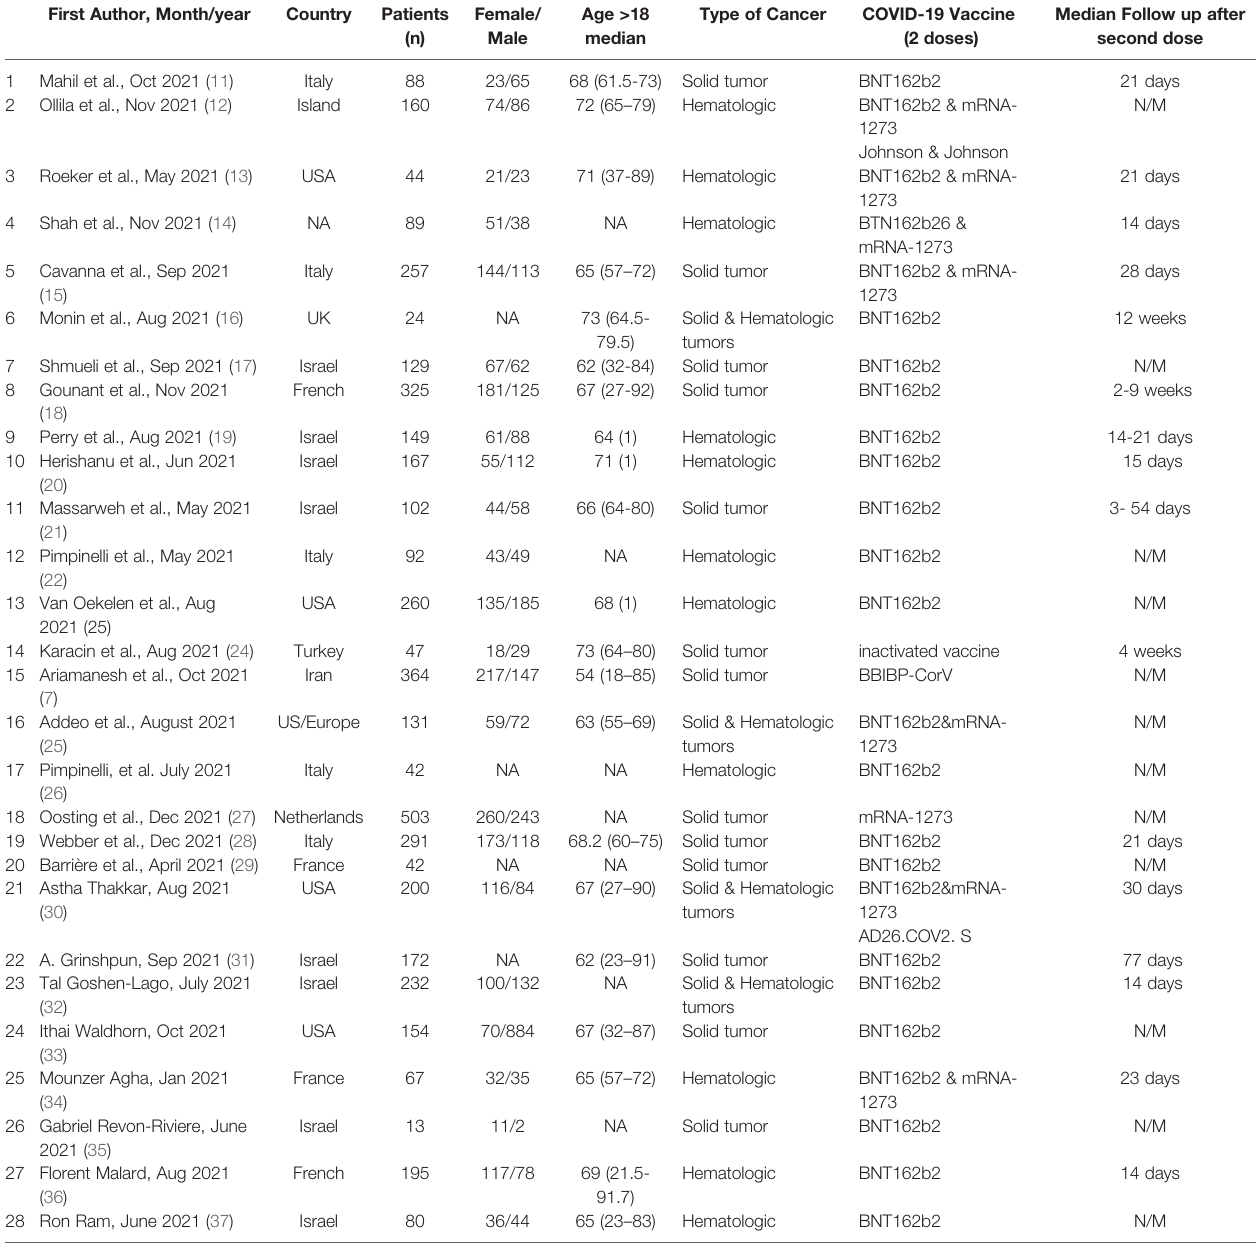
TABLE 2 | Characteristics of enrolled studies to